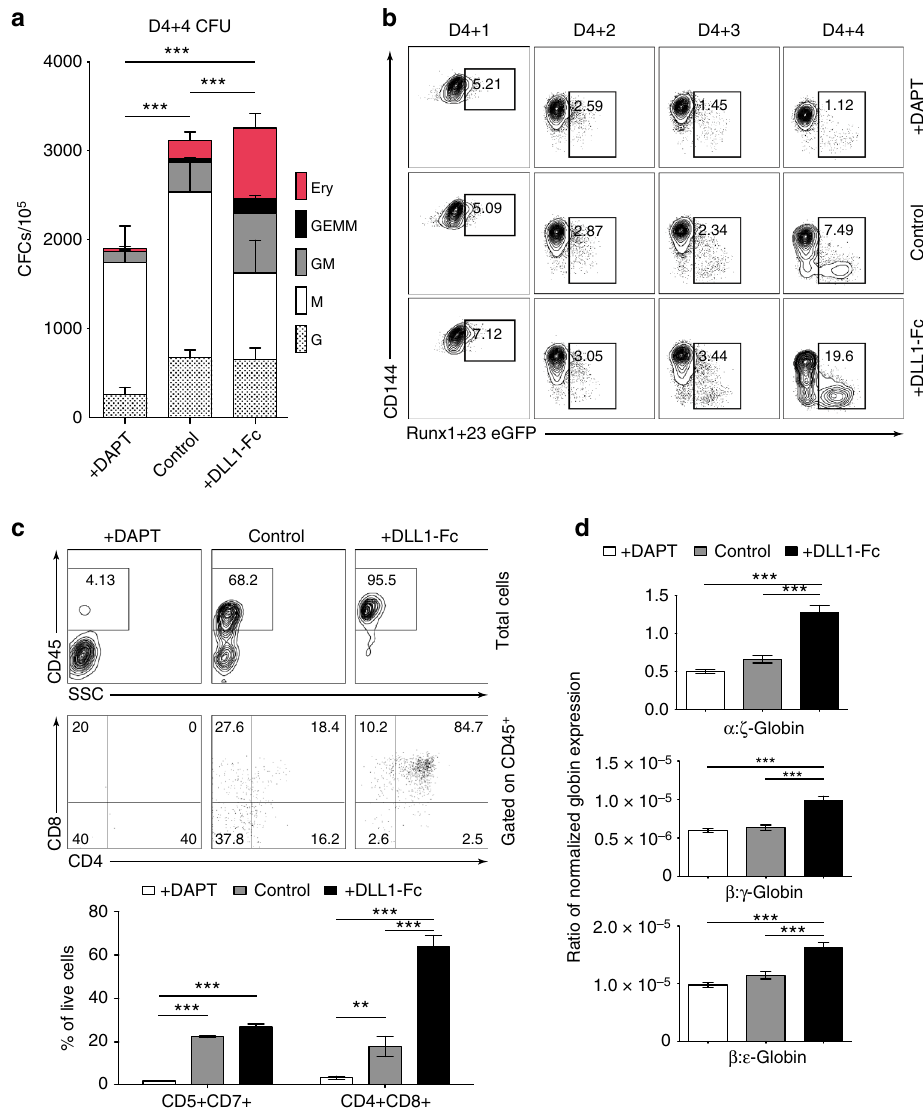
Fig. 3 NOTCH activation at HE stage increases de fi nitive hematopoiesis. a D4 HE were cultured with DAPT or in the presence of DLL1-Fc (see Fig. 1b schematic diagram). Cells were collected after 4 days of differentiation (D4 + 4) and used to determine frequencies of hematopoietic progenitors in CFU assay. Increase in multipotential GEMM and GM colonies in the DLL1-Fc culture condition suggests that NOTCH activation supports expansion of the most immature HPs. Results are mean ± s.e.m. for three independent experiments; two-way ANOVA Bonferroni post-hoc test, *** p < 0.001 b Flow cytometric analysis of Runx1 + 23-eGFP transgene expression in D4 HEPs cultured with DAPT or on DLL1-Fc. Runx1 + 23 enhancer activity increases in the cultures plated on DLL1-Fc and decreases in the DAPT-treated cultures. Representative contour plots from three independent experiments are shown. c T-cell potential of HP collected after 4 days of culture D4 HEs in presence of DAPT or DLL1-Fc. Bars show mean ± s.e.m. for three independent experiments; one- way ANOVA Bonferroni post-hoc test, ** p < 0.01, *** p < 0.001. d Ratio of α / ζ , β / γ , and β / ε globin chain expression in erythroid cultures generated from D4 HE in presence of DAPT or DLL1-Fc. Results are mean ± s.e.m. for three independent experiments; one-way ANOVA Bonferroni post-hoc test, *** p <